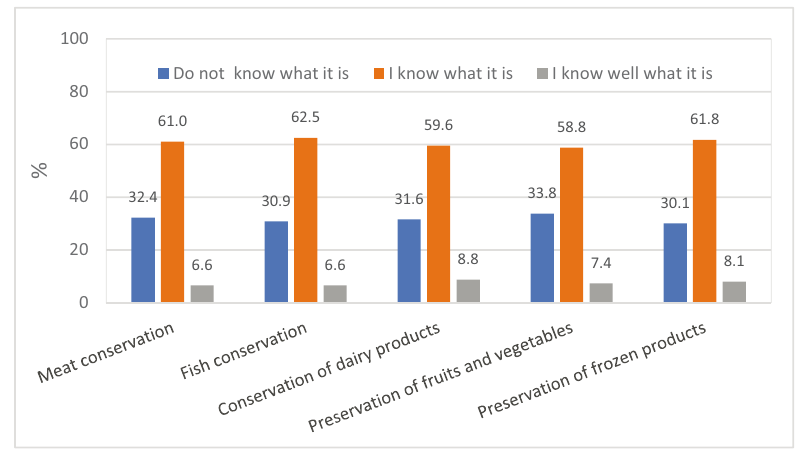
Figure 2: Results for the question: “ Indicate your level of knowledge about the RDC used in each of the food conservation applications ”